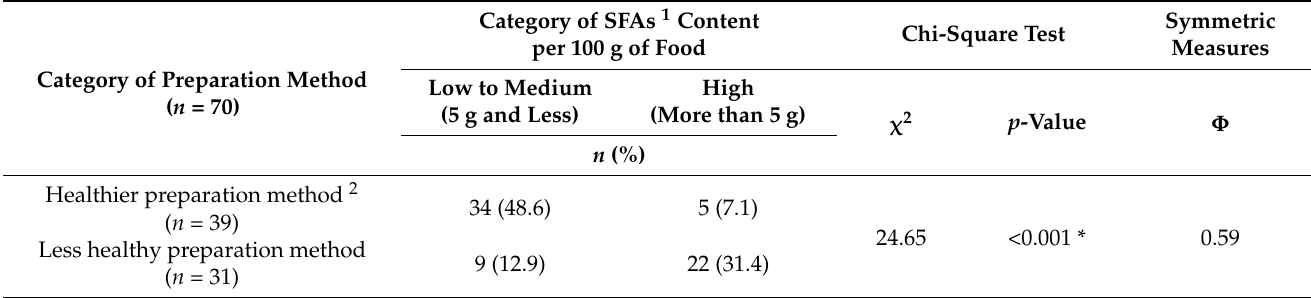
Figure 2. Percentage of street foods ( n = 70) based on the classification of preparation methods and SFAs content in 100 g of food. Table 3. Association between preparation methods and SFAs 1 content of street foods ( n = 70).